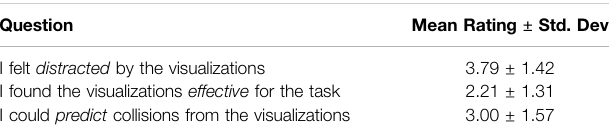
TABLE 1 | General ratings on the visualizations from 1 – 5 (1 (cid:1) strongly agree, 5 (cid:1) strongly disagree). Question Mean Rating ± Std. Dev